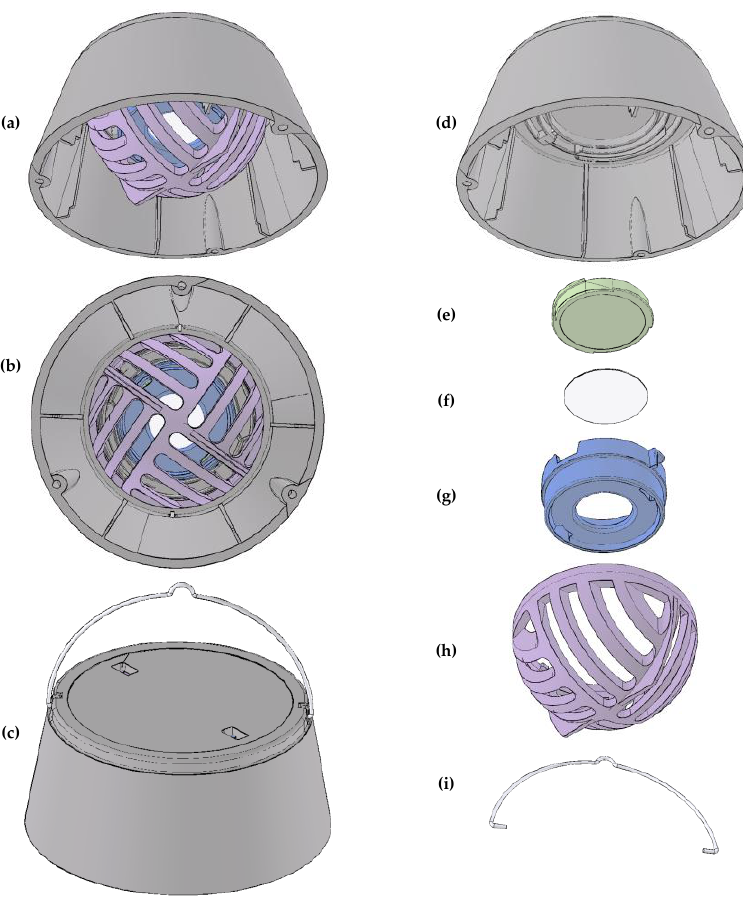
Figure 1. The assembled low-cost passive sampler, shown from ( a ) side, ( b ) bottom, and ( c ) top, and its components, including the ( d ) cap, ( e ) base for paper filter exposure surface, ( f ) paper filter exposure surface, ( g ) clamp for paper filter exposure surface, ( h ) protective cage, and ( i ) wire for hanging sampler.